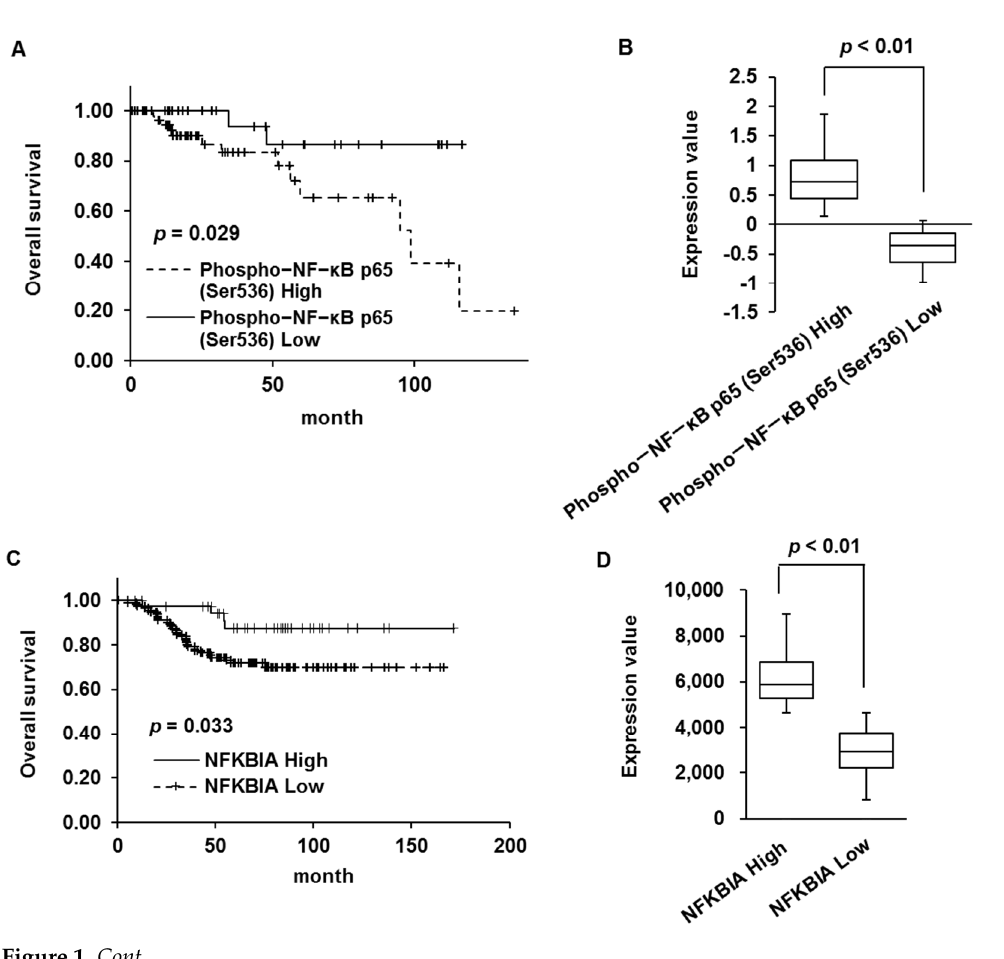
Figure 1. Activation of NF- κ B p65 was associated with poor prognosis in patients with TNBC. ( A ) Relation between phospho-NF- κ B p65 (Ser536) expression and overall survival. Survival rates were appraised using Kaplan − Meier Plotter. ( B ) High and low phospho-NF- κ B p65 (Ser536) expression groups were analyzed using Kaplan − Meier Plotter. ( C ) Relation between NFKBIA expression and overall survival. Survival rates were appraised using Kaplan − Meier Plotter. ( D ) High and low NFK- BIA expression groups were analyzed using Kaplan − Meier Plotter. ( E ) Expression of RELA in TNBC and normal tissues was analyzed using the GSE45827 dataset. 2.2. DMF Induced Apoptosis in MDA-MB-231 and BT549 Cells We investigated the activation and expression of NF- κ B and I- κ B α in MCF-10A, MDA-MB-231, and BT-549 cells. The activation and expression of NF- κ B p65 were higher in MDA-MB-231 and BT-549 cells than in MCF-10A cells (Figure 2). In addition, the ex- pression of I- κ B α was lower in MDA-MB-231 and BT-549 cells than in MCF-10A cells (Fig- ure 2). Next, we investigated the cytotoxic effects of DMF in MCF-10A, MDA-MB-231, and BT-549 cells. The cells were treated with 1–50 μ M DMF, and the cell survival rate was examined. DMF markedly diminished the survival of MDA-MB-231 and BT-549 cells but did not affect the survival of MCF-10A cells (Figure 3A). In addition, DMF markedly in- creased the number of Annexin V–positive cells and the expression of cleaved caspase-3 in MDA-MB-231 and BT-549 cells (Figure 3B,C). These results suggest that DMF induces apoptosis in TNBC cells at concentrations that do not affect normal breast epithelial cells.